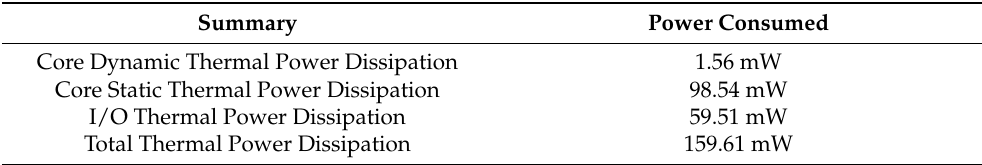
Table 5. FPGA Power Consumption